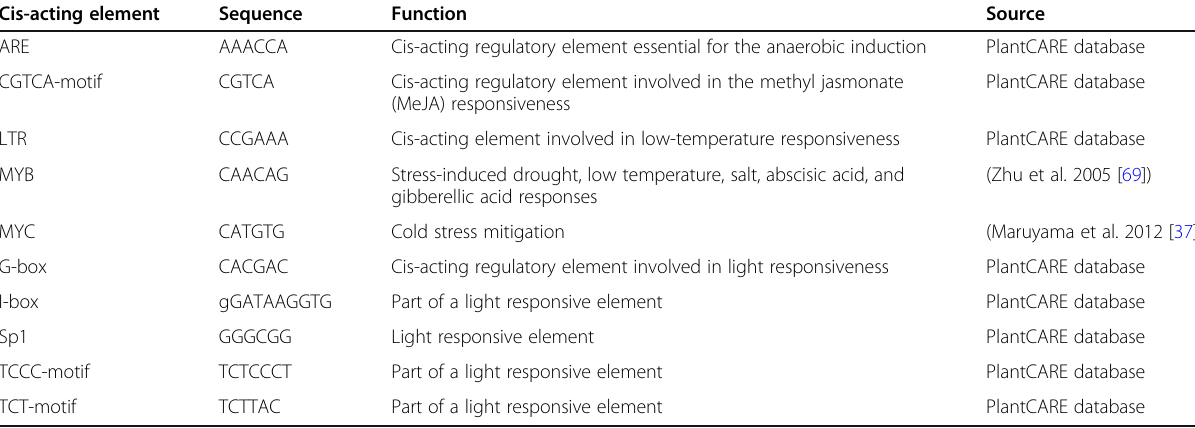
Table 1 Predicted cis-elements in the promoter regions of the OsMYB59 indica gene responsive to stresses and light Cis-acting element Sequence Function Source ARE AAACCA Cis-acting regulatory element essential for the anaerobic